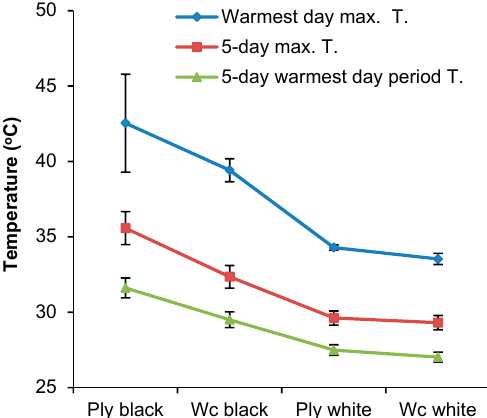
Figure 3. Summary of comparisons of mean (±SE) front chamber temperatures for each box design (n = 4) during the periods of examination: T box_max on warmest summer day (ambient: 35.4 °C), 5-day T box_max (ambient: 29.3 °C ± 1.0) and 5-day T box_warmest (ambient: 27.2 °C ± 0.3). ply = plywood; wc = wood-cement. Table 2. Pairwise comparison of temperatures in front chambers (n = 4) between box designs for 5-day